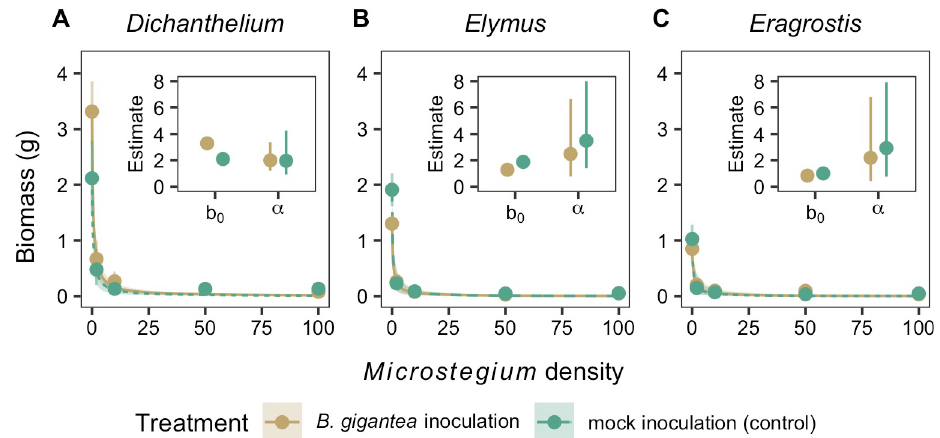
Fig 5. Native plant biomass. The biomass of (A) Dichanthelium , (B) Elymus , and (C) Eragrostis across the Microstegium density gradient following B . gigantea or mock inoculation. Main plots show observations (points and error bars, mean ± 95% confidence intervals) and model fits (lines and shaded ribbons, mean ± 95% credible intervals). Inset plots show the model-estimated biomass in the absence of competition (b 0 ) and the biomass responses to Microstegium density ( α ) (mean ± 95% credible